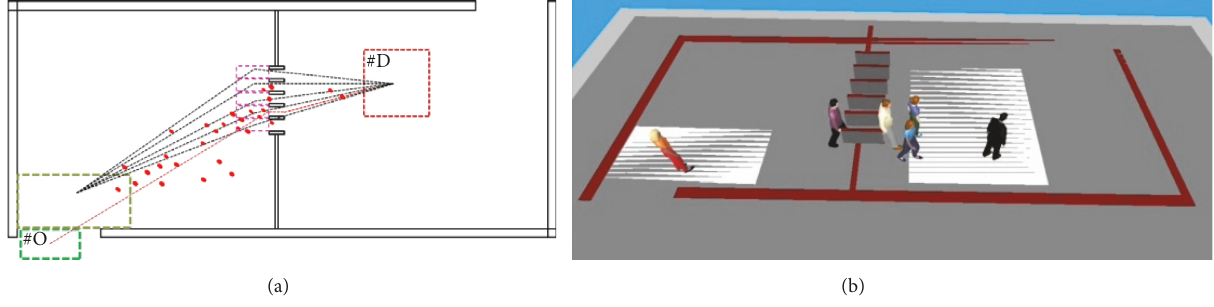
Figure 17: A simulation snapshot by (a) our tool and (b)